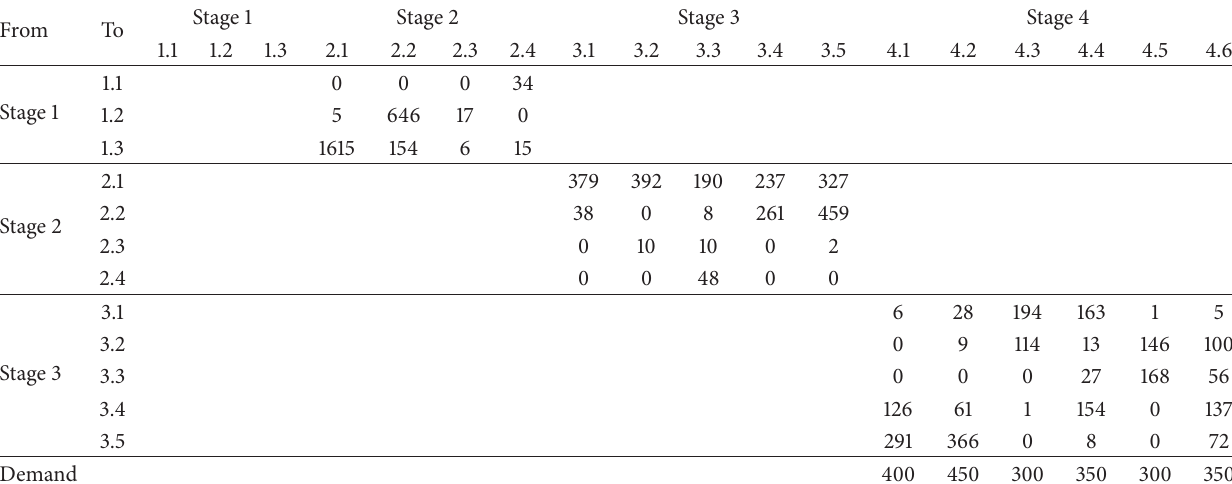
Table 13: The first period transportation plan by PSOA IWM.